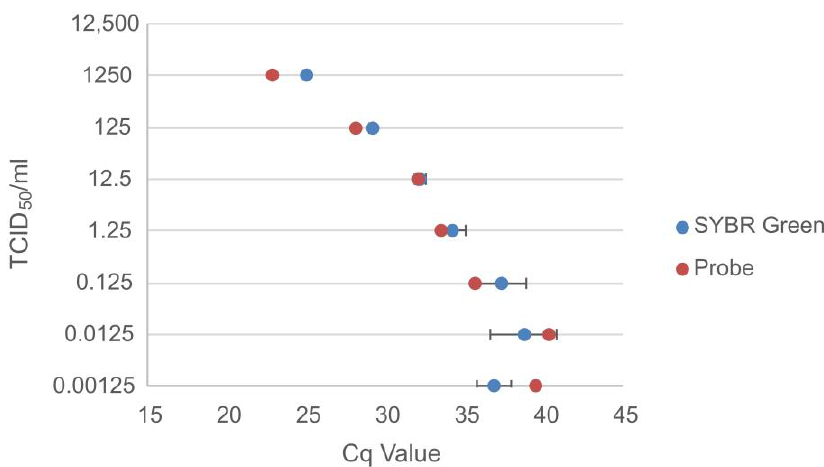
Figure 7. Comparison of the Cq values for the probe-based assay and the average Cq values for the SYBR Green assay for the negative bat sera spiked with the titrated (TCID 50 /mL) serially diluted Ebola virus.